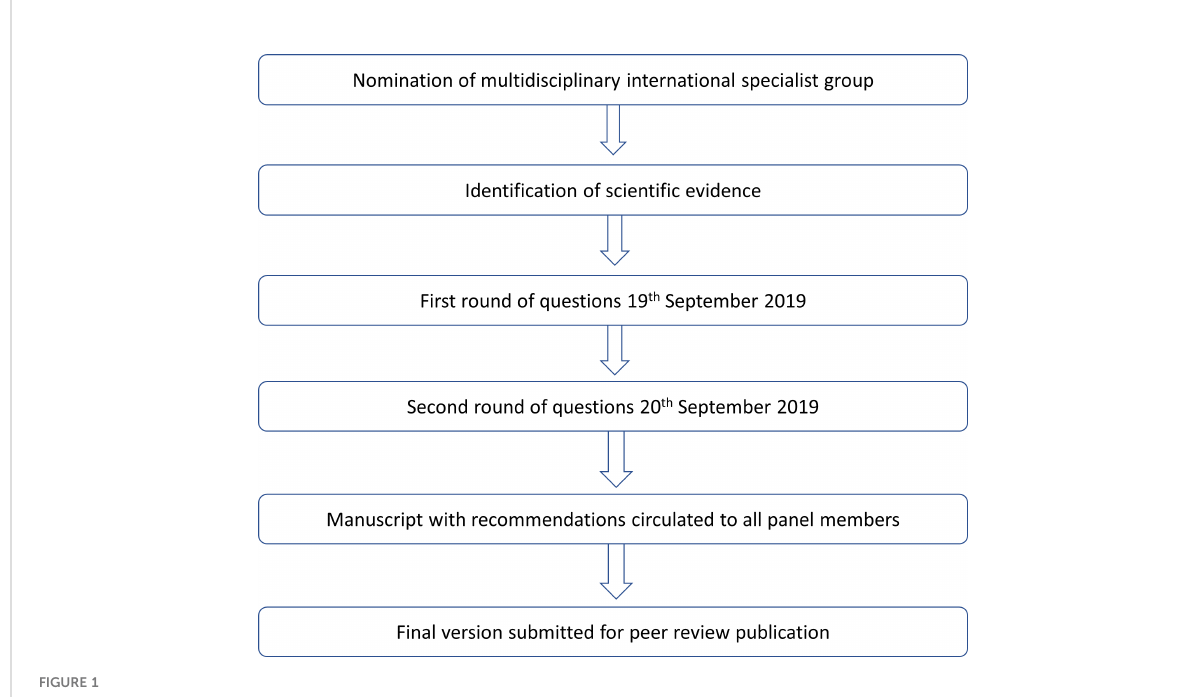
FIGURE 1 Development